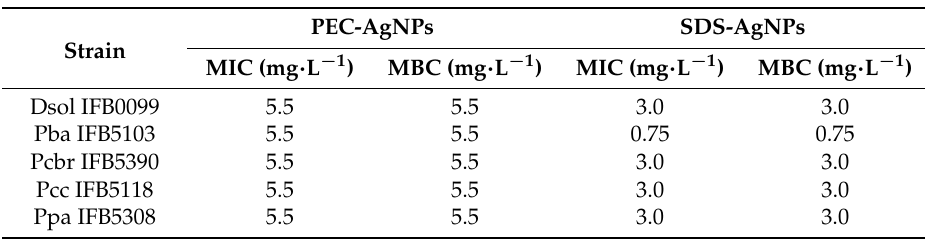
Table 1. Antibacterial activity of PEC-AgNPs and SDS-AgNPs against Dickeya spp. and Pectobacterium spp. Values are based on two replicates, and identical results for each replicate were